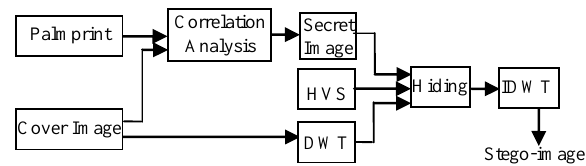
Fig. 1. The flowchart of proposed hiding